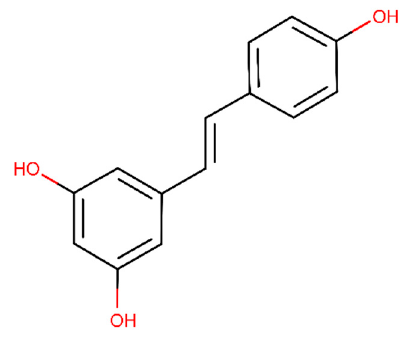
Figure 8. Chemical structure of resveratrol.